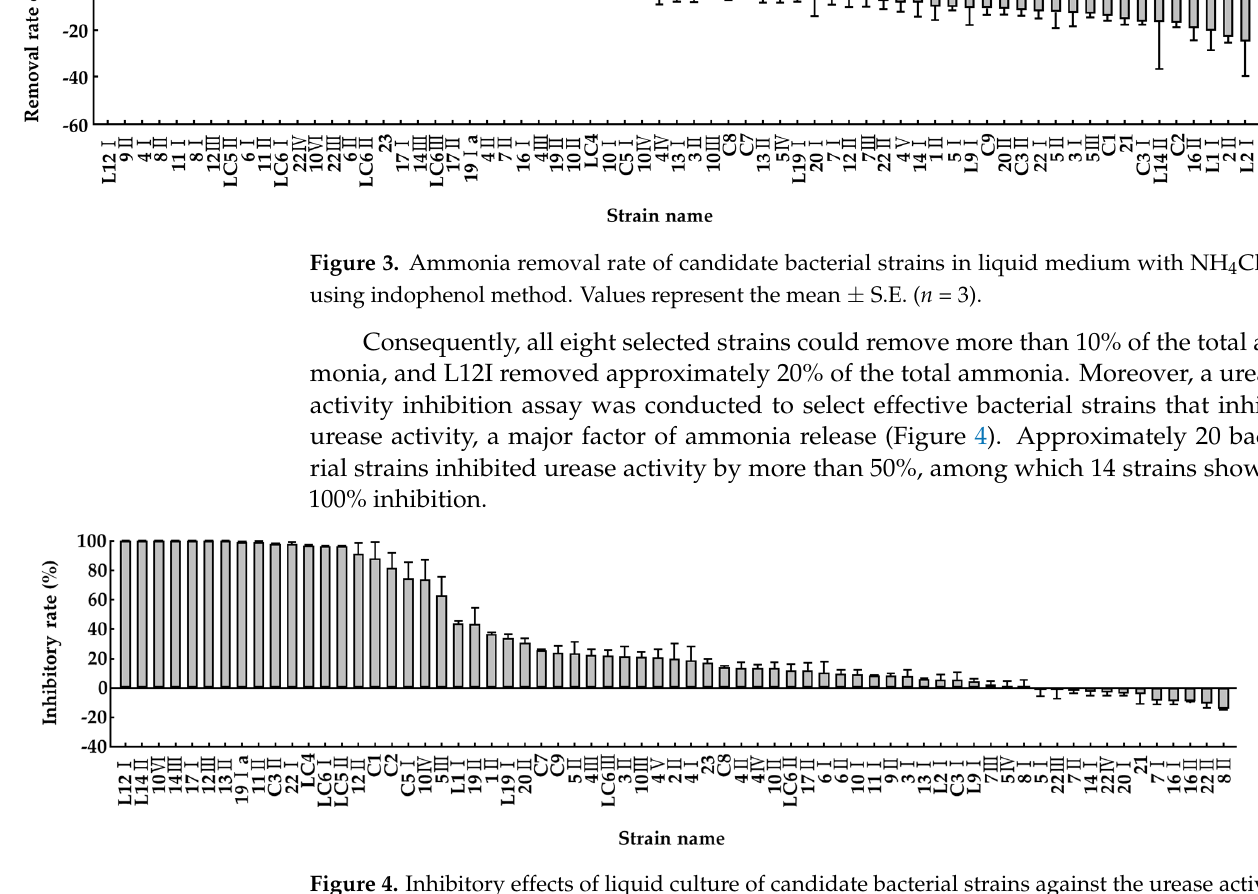
Figure 2. Changes of pH in culture medium of candidate bacterial strains. Values represent the mean ± S.E. ( n = 3).